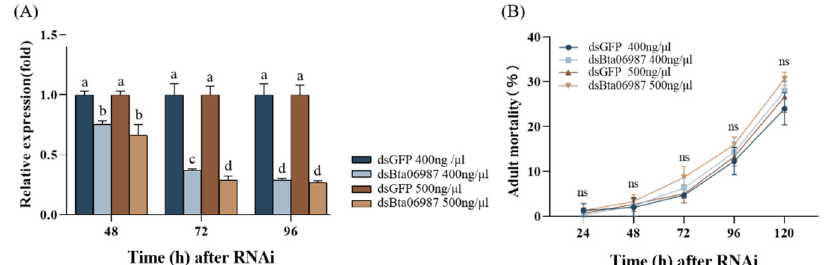
Figure 3. Effect of different doses of dsRNA in ( A ) the relative gene expression of Bta06987 with different time in whiteflies and on ( B ) the mortality of whiteflies with different time. RNAi was performed in 48 h, 72 h, and 96 h with 400 ng µ L − 1 and 500 ng µ L − 1 .The mortality was estimated every 24 h from 24 to 120 h. All data are presented as the mean ± SEM and evaluated by one-way ANOVA analysis and Duncan’s multiple-range test. Different letters on the histogram indicated significant differences at p < 0.05. The ‘ns’ on the line indicated on significant difference at p > 0.05.